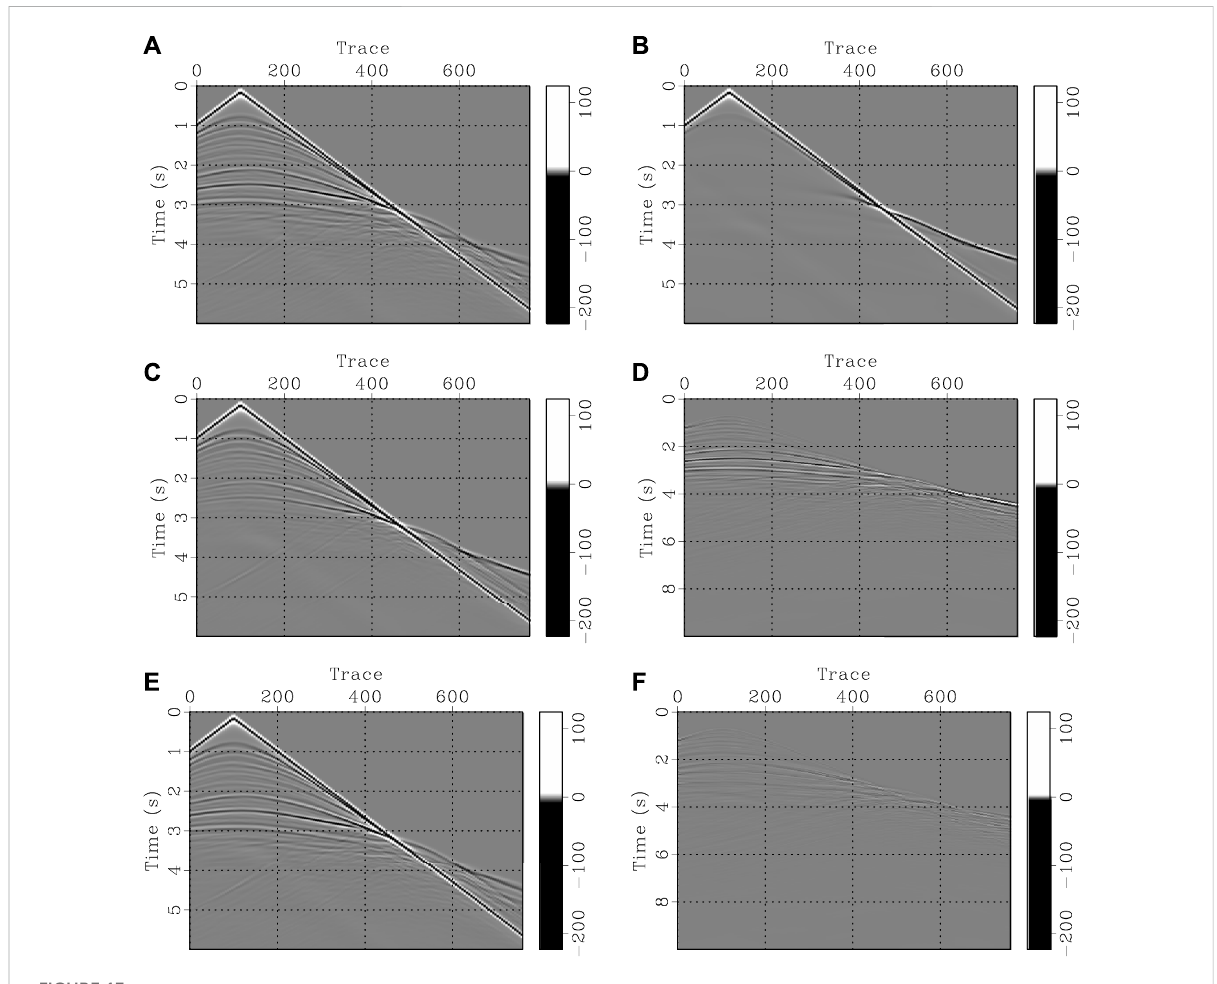
FIGURE 13 Comparisons of common-shot gathers for Marmousi model. (A) Observed data, (B) synthetic data using initial model; (C) synthetic data using CSV-basedFWIvelocitymodel, (D) differencebetween (A) with (C) ; (E) syntheticdatausingrecoveredvelocitymodelfromtheproposedmethod, (F) difference between (A,E)